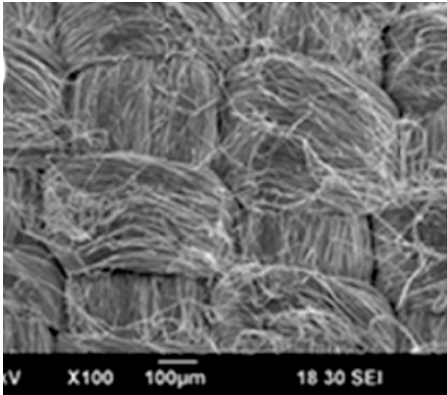
Figure 3. Scanning electron microscope (SEM) image of woven structure obtained using the electrospun yarns. Reprinted with permission from John Joseph, Shantikumar V. Nair, Deepthy Menon, Integrating substrateless electrospinning with textile technology for creating biodegradable three-dimensional structures, Nano Letters 2015 , Vol 15, 5420–5426. Copyright (2015), American Chemical Society.